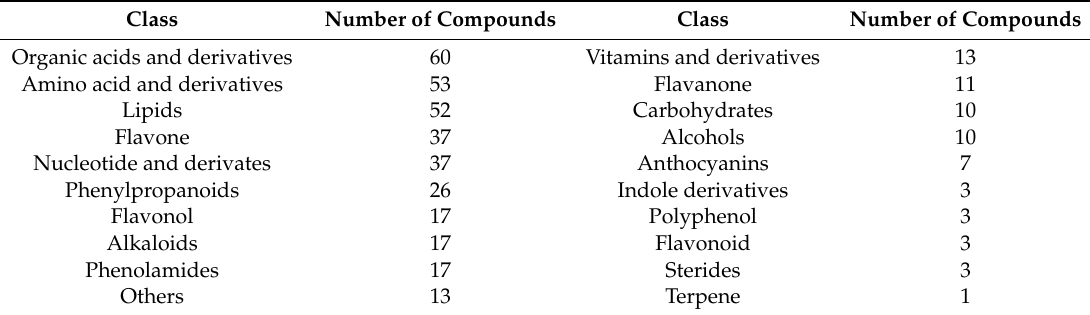
Table 1. Classification of the detected metabolites in wolfberry fruit into major classes.